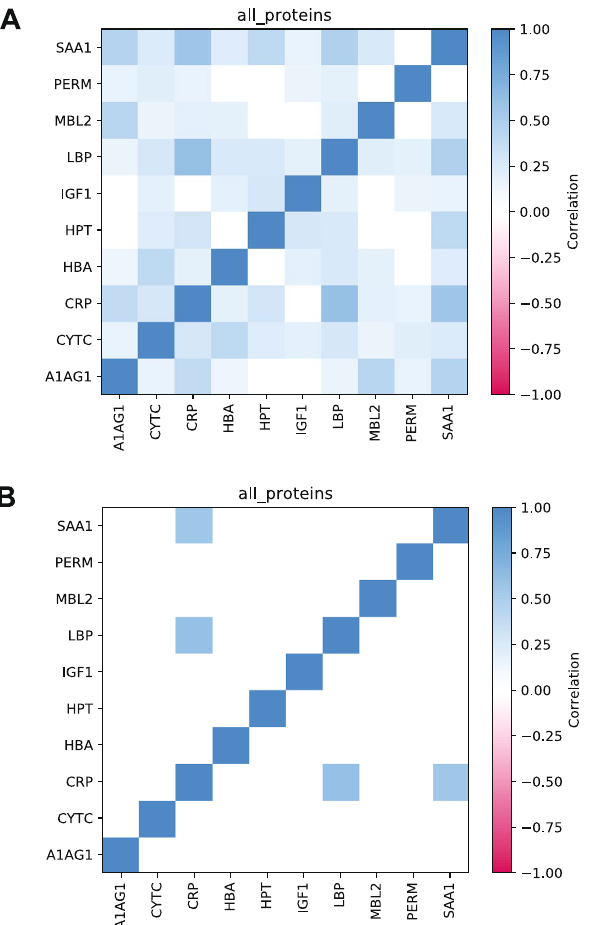
Figure 3. There are two high protein pair correlations p < 0.001 and r s > 0.5. Matrix of pairwise correlations among proteins, considering all sports, athletes and states. ( A ) Significant protein pairs correlations at p value < 0.001 are highlighted; ( B ) Significant protein pairs correlations r s > 0.5 are highlighted ( p < 0.001). n = 97. Full data are presented in Supplementary Material 1. Alpha-1-acid glycoprotein—A1AG1; Albumin—ALBU; Cystatin C—CYTC; C-reactive protein CRP; Hemoglobin beta chain—HBA; Haptoglobin—HPT; Insulin- like growth factor 1—IGF1; Lipopolysaccharide binding protein—LBP; Mannose-binding lectin—MBL2; Myeloperoxidase—PERM and Serum amyloid